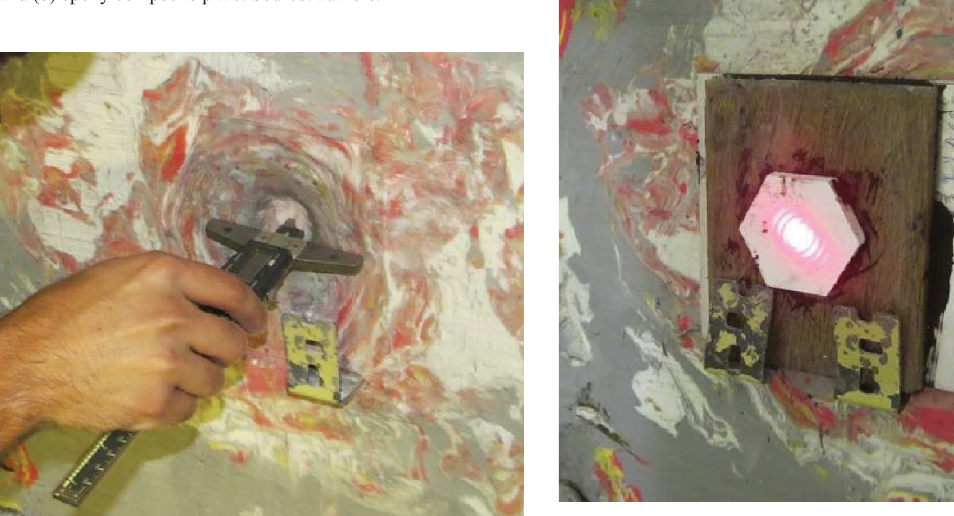
Figure 2. Giant bamboo fiber composite: (a) schematic production and (b) epoxy composite plate. Source: authors.